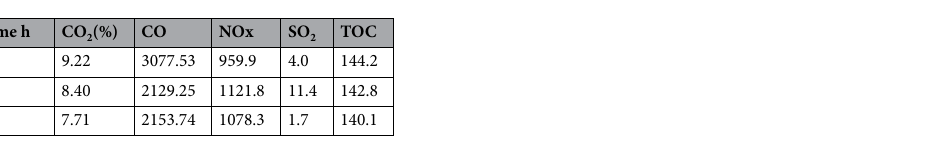
Table 7. Emission levels at different hours expressed in mg/Nm 3